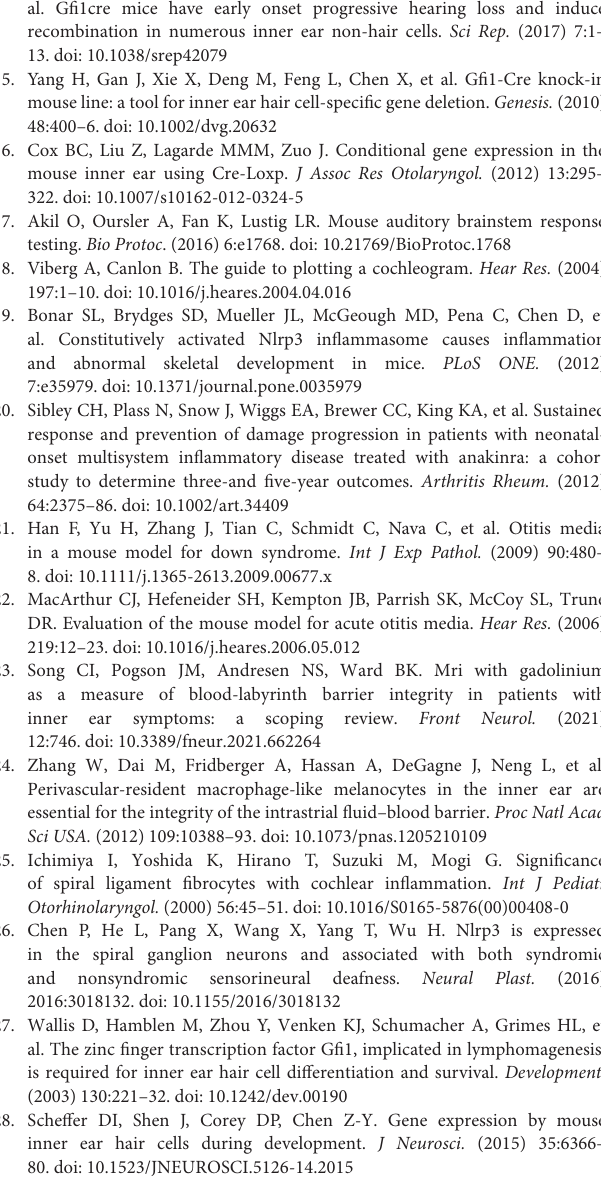
cells in segments spanning 1% of the whole cochlear length in P15 Nlrp3 D 301 NneoR / + /+ ; Gfi1 Cre / + mice ( n = 6 cochleae) and Nlrp3 D 301 NneoR / + ; Gfi1 + / + mice ( n = 6 cochleae) were not different. Supplementary Figure 3 | Cochlear morphology of Nlrp3 + / + ; Gfi1 Cre / + mice at P15. Sections of the cochlea of Nlrp3 + / + ; Gfi1 Cre / + mice did not show collapsed morphology of the organ of Corti, unlike the Nlrp3 D 301 N / + ; Gfi1 Cre / + mice. P15, postnatal day 15. Supplementary Figure 4 | Differences in the morphology of Nlrp3 D 301 N / + ; Gfi1 + / + mice compared to Nlrp3 D 301 N / + ; Gfi1 Cre / + mice. At P11, two Nlrp3 D 301 NneoR / + ; Gfi1 Cre / + mice were smaller (2.8g and 3.1g vs. 6.8g) and showed more extensive areas of skin inflammation with hair loss than the Nlrp3 D 301 N / + ; Gfi1 + / + mouse (left). P11, postnatal day